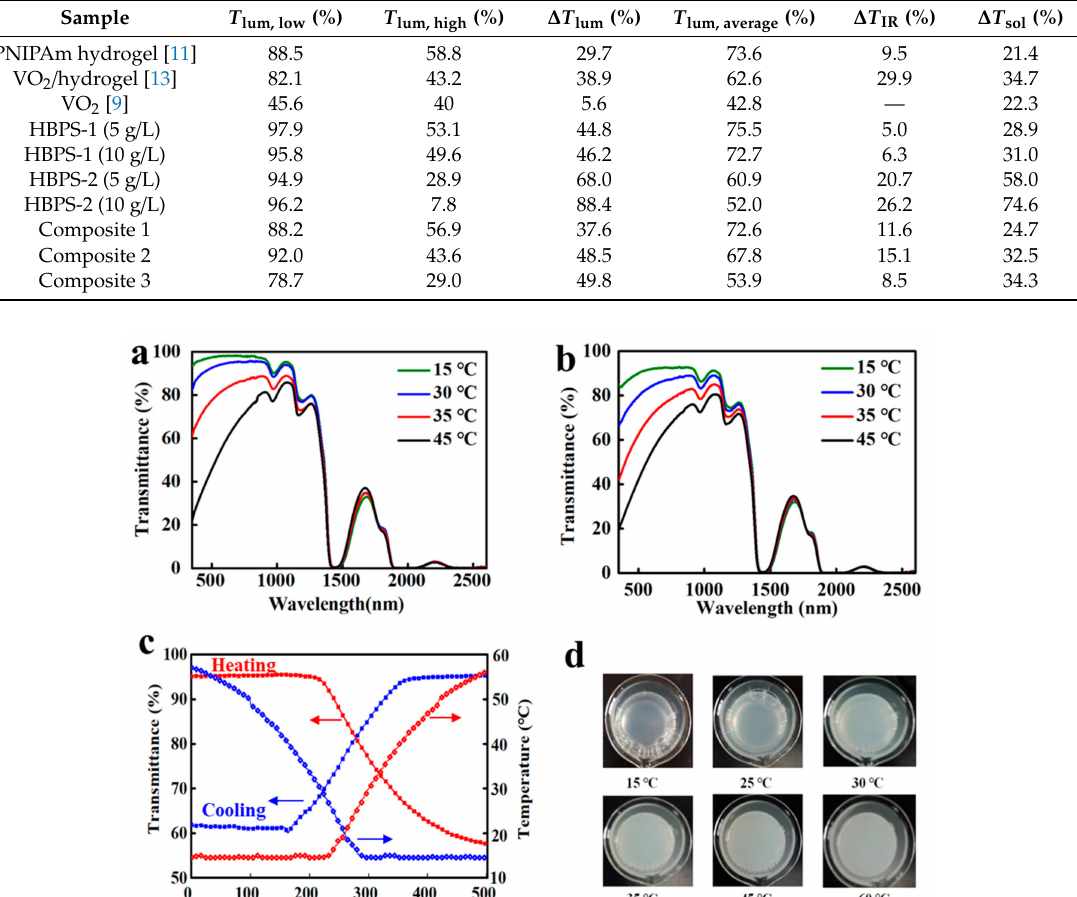
Table 2. Comparison of the optical properties between composites 1, 2, and 3 and poly ( N -isopropylacrylamide) (PNIPAm) hydrogel, VO 2 / hydrogel hybrid, and VO 2 .